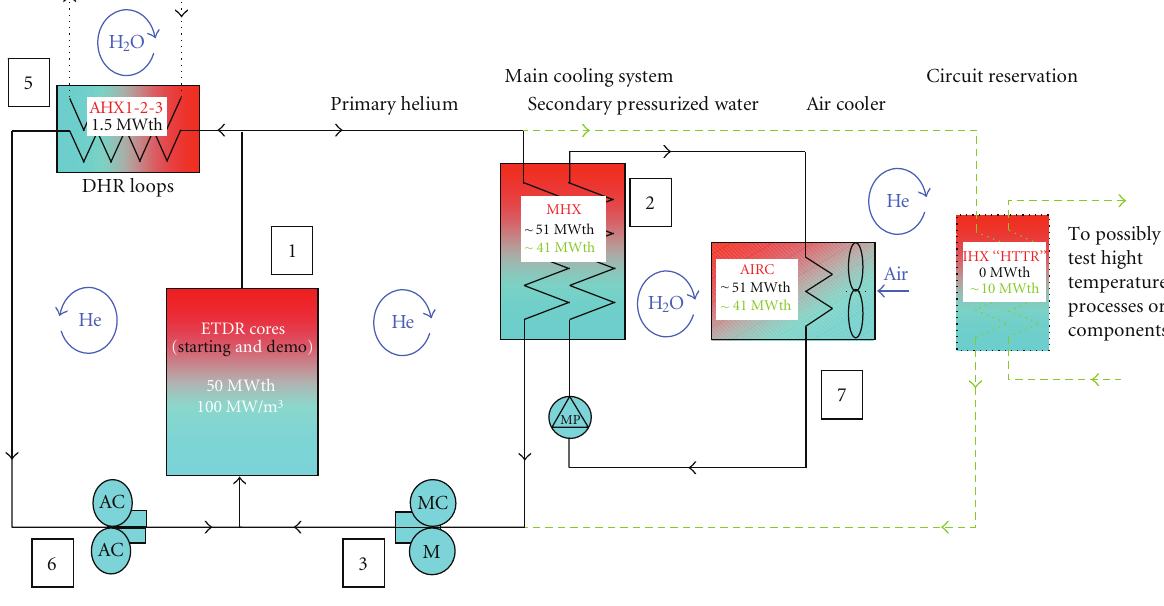
Figure 3: ETDR flux diagram